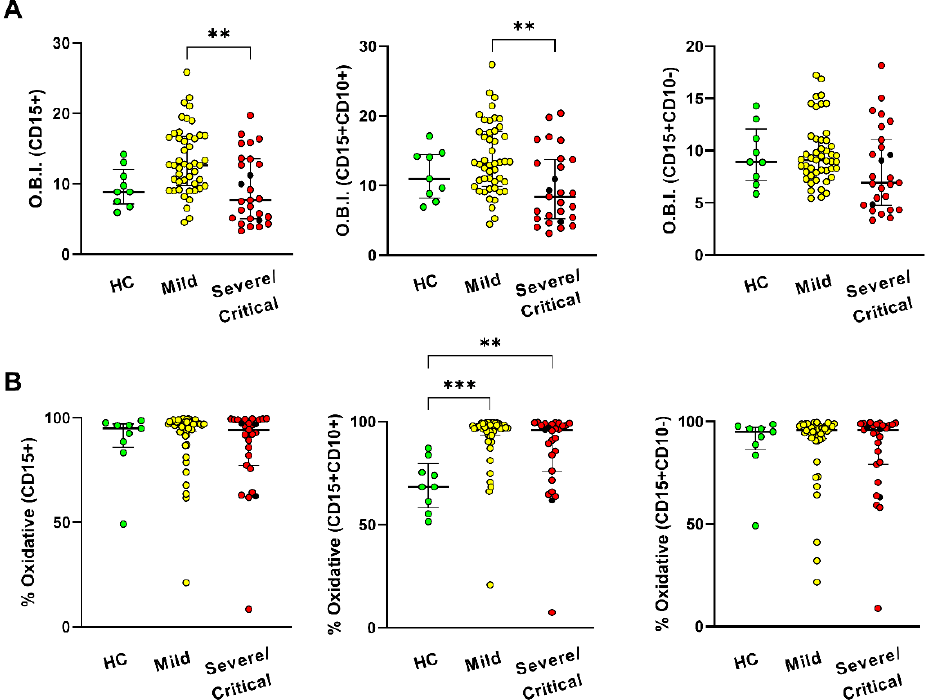
Figure 5. CD15+CD10+ neutrophils with increased respiratory burst in mild COVID-19 infection. DHR oxidation assay was analyzed in neutrophils from patients with COVID-19 (moderate ( n = 47), severe ( n = 3), and critical ( n = 24)), compared with healthy subjects (HC, n = 9) by flow cytometry. ( A ) Index of the data of Oxidative Burst Index (O.B.I) ( B ) oxidative percentage. CD15+CD10+ cells represent mature neutrophils and CD15+CD10- cells that represent immature neutrophils. Data show the median and interquartile range. * p ≤ 0 .05, ** p ≤ 0 .01, *** p ≤ 0 .001 and **** p ≤ 0 .0001.